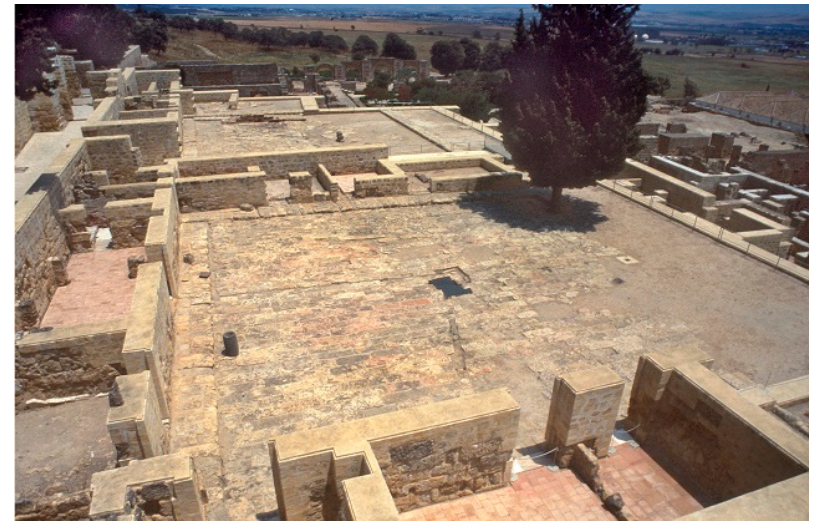
Figure 19. Upper Buildings, Nos. 6 and 7. © Conjunto Arqueológico de Madinat al-Zahra.